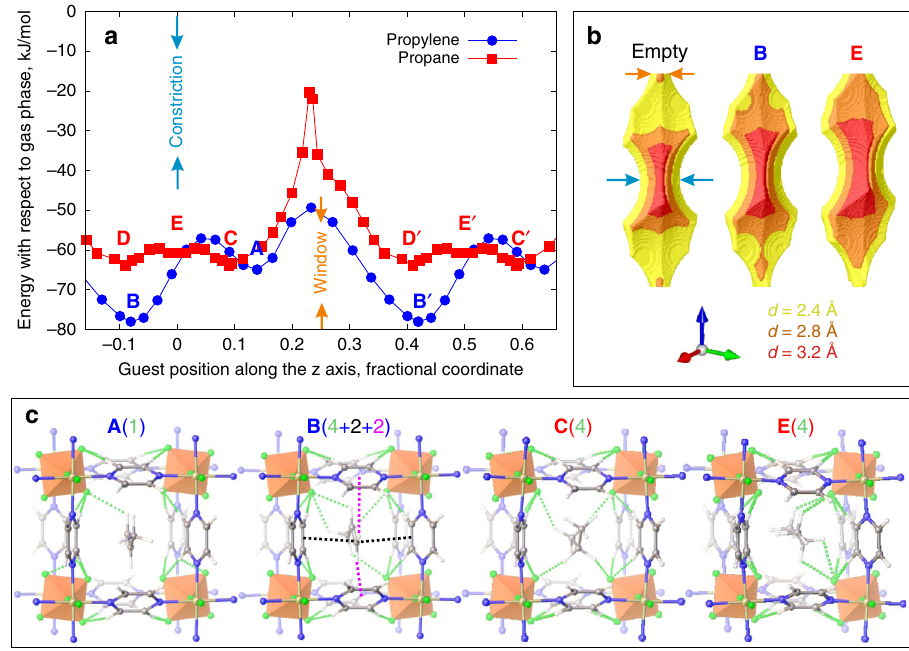
Fig. 5 DFT calculations for SIFSIX-3-Ni. a Complete MEPs calculated using the climbing image NEB DFT method for propylene (circles) and propane (squares). The energy relative to the lowest energy con fi guration is shown as a function of the position of the central carbon on the C 3 H 6 or C 3 H 8 guest molecule. The position of the Ni-pyrazine layer at z = 0.25 separating two adjacent cavities (centred at z = 0 and z = 0.5) is noted by orange arrows. b The shape of the cavity of an empty SIFSIX -3-Ni host and con fi gurations B and E . Unlike in NbOFFIVE -1-Ni, the local energy minimum E is metastable and does not show any signi fi cant anion rotations. Similar to propylene, in SIFSIX -3-Ni propane preferentially resides near the window in one of the equivalent sites C or D , in contrast to the behaviour in NbOFFIVE -1-Ni. c , the snapshots show the stable con fi gurations for propylene ( A and B ) and propane ( C and E ) with the total number of the C – H···F contacts shorter than 2.67 Å indicated in brackets. π – π (black dotted lines) and C – H··· π (magenta dotted lines) interactions are shown for